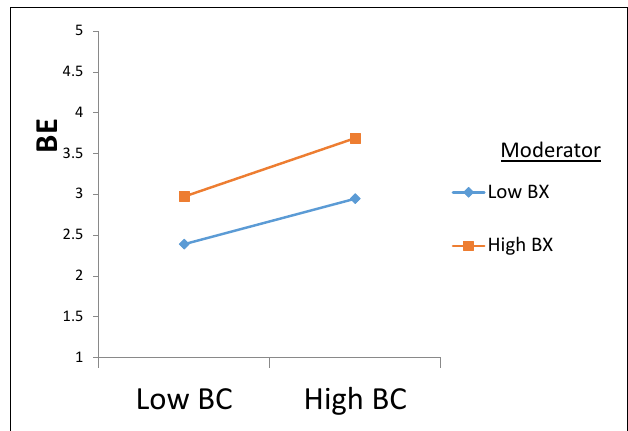
FIGURE 3 | Graphical representation of moderating brand